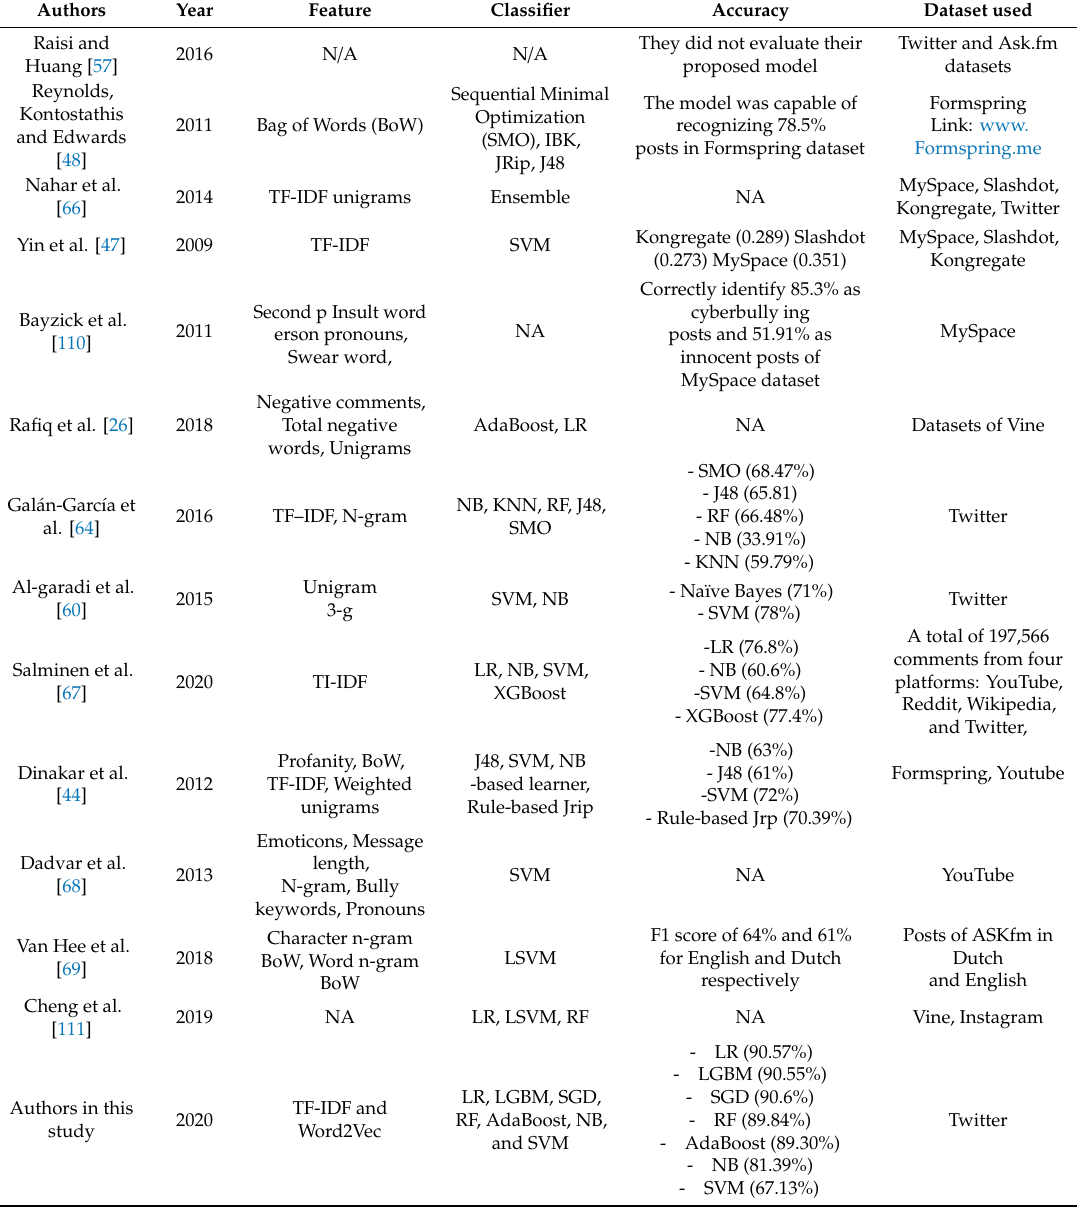
Table 1. Comparison of The Related